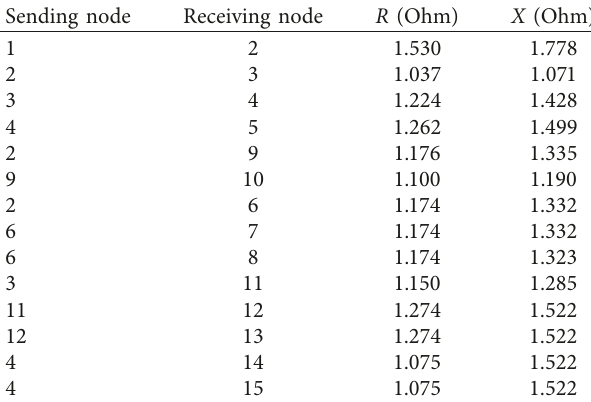
Table 3: Line data of the 15-bus system.